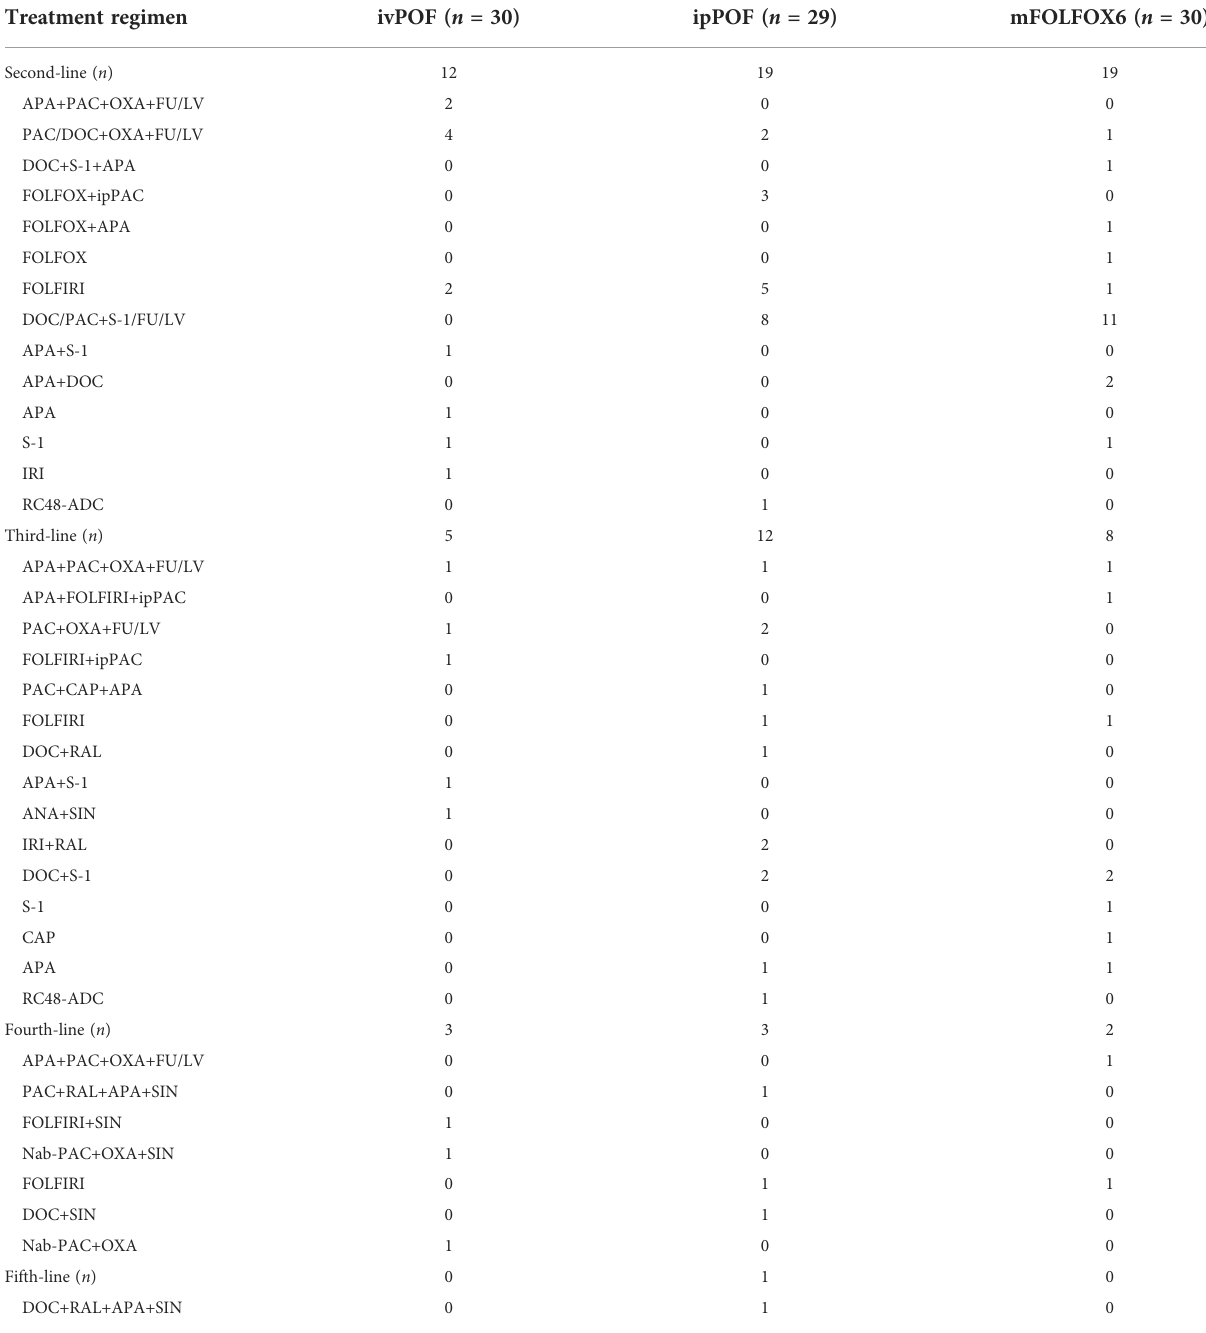
TABLE 5 Subsequent